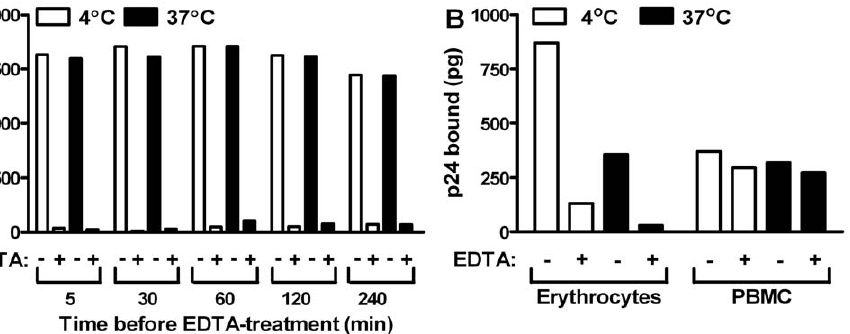
Figure 4. HIV-1 bound to the erythrocyte cell preparation is not internalized by contaminating leukocytes at 37 u C. (A) Erythrocytes (donor R9) were first incubated with HIV-1 (isolate 89BZ_167) at 4 u C for 2 hr and binding was determined. The cells were then incubated further at either 4 u C or 37 u C, and at the indicated times 10 ml of 5 mM EDTA (Na salt) were added and p24 associated with the cells was measured. The experiment shown was performed twice with similar results. (B) In a further experiment, containing a positive control, erythrocytes (donor T4) and PBMC were first incubated with HIV-1 (isolate 89BZ_167) either at 4 u C or 37 u C for 2 hr and binding was determined. The cells were then incubated for 4 hours at either 4 u C or 37 u C then treated with 5 mM EDTA (Na salt). Cells were washed and p24 associated with the cells was measured.